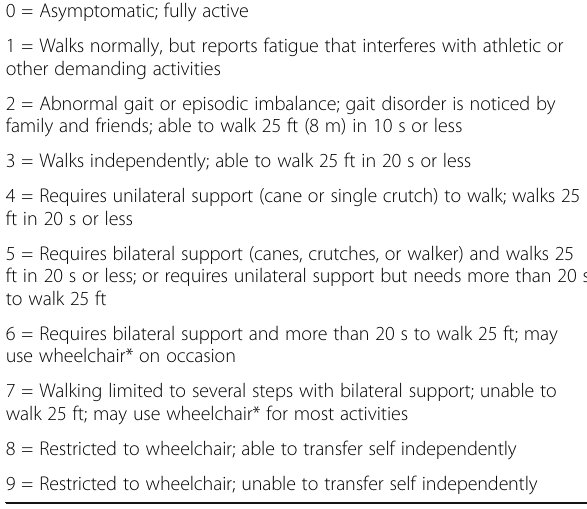
Table 1 Hauser Ambulation index